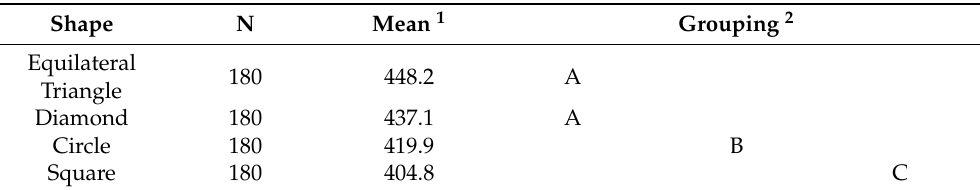
Table 6. Tukey post-hoc analysis for shape and MT . The longest MT was the equilateral triangle and the shortest that of the square.